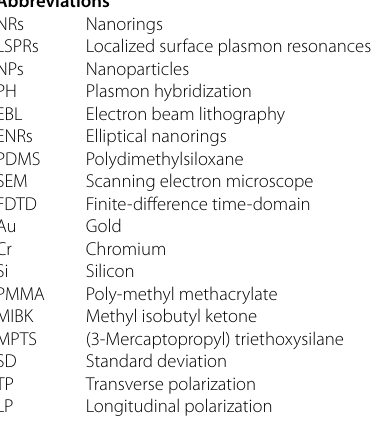
Fig. S3. Effective length models for the nanorod and nanoring. Figs. S4‑S6. Supplementary